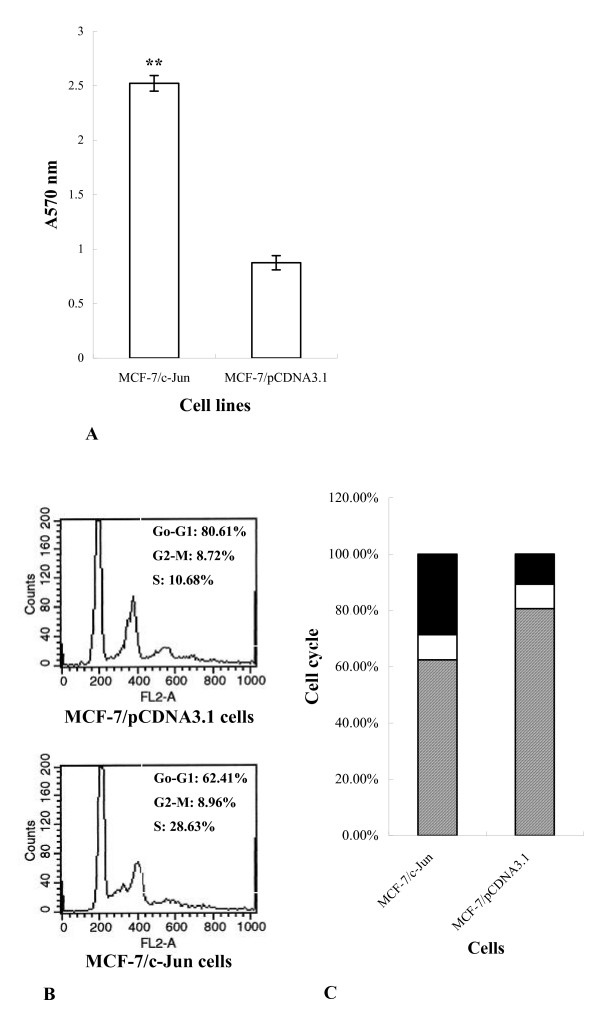
Effect of c-Jun expression on the proliferation and cell cycle of MCF-7 cells. A, proliferation assay. Cells (3.5 × 103/well) were cultured for continuous five days and proliferation of MCF-7/c-Jun cells was measured in an MTT-based assay. ** P < 0.01 B and C, cell cycle analysis. MCF-7 cells were washed with cold PBS and fixed in cold 70% (v/v) ethanol at 4°C for at least 18 hours. Then the cells were incubated with RNase A (100 μg/ml) at 37°C for 30 minutes and stained with propidium iodide (PI) (50 μg/ml) in the dark at 4°C for 20 minutes. DNA content was measured by flow cytometry. Striped column, G0-G1 phase; empty column, G2-M phase; solid column, S phase.